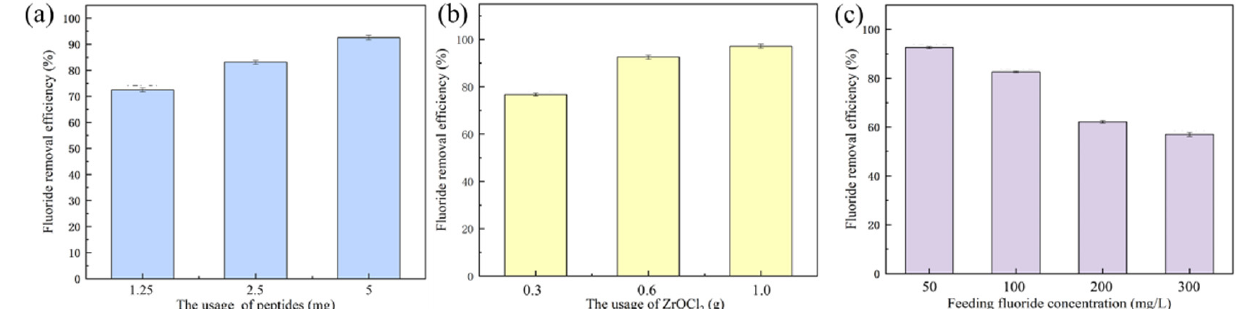
Figure 7. F − ion adsorption experiments: ( a ) removal efficiency of biomimetic inorganic-organic hybrid membranes with various PNF dosages, ( b ) removal efficiency of biomimetic inorganic-organic hybrid membranes with various ZrO 2 loading, and ( c ) Removal efficiency of membranes towards F − -containing samples.